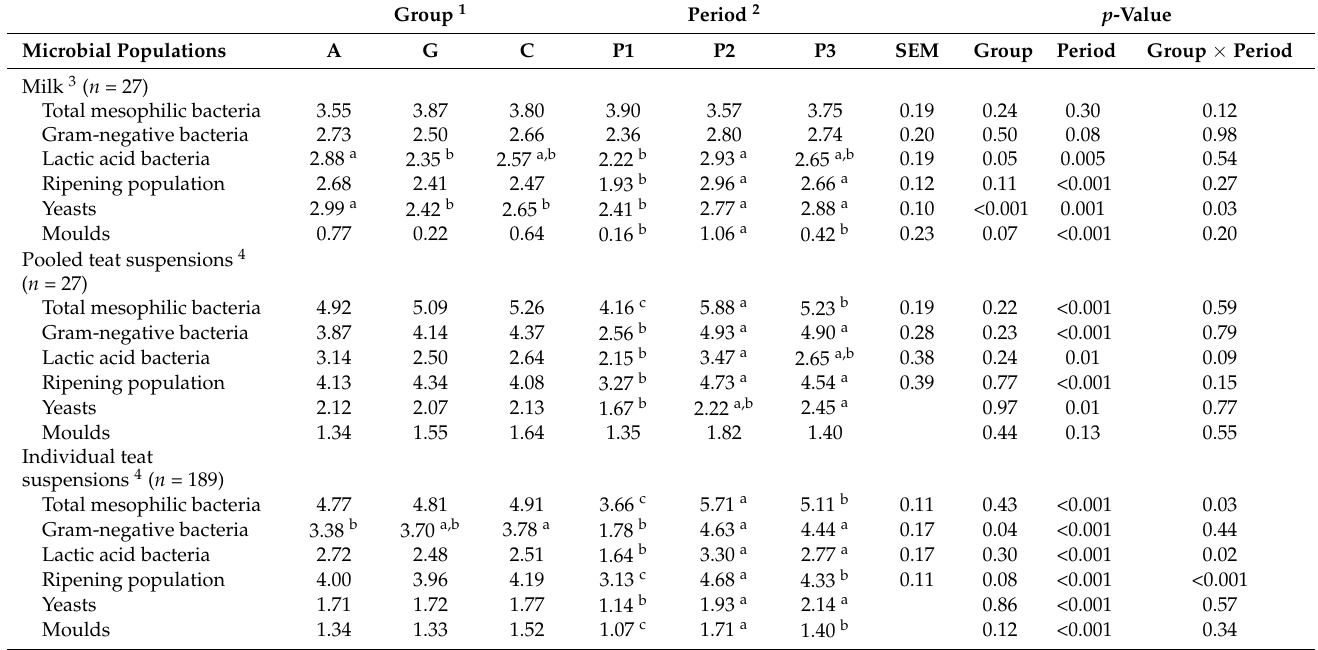
Table 3. Effect of post-milking treatment and period on milk and teat microbial concentrations. Group 1 Period 2 p